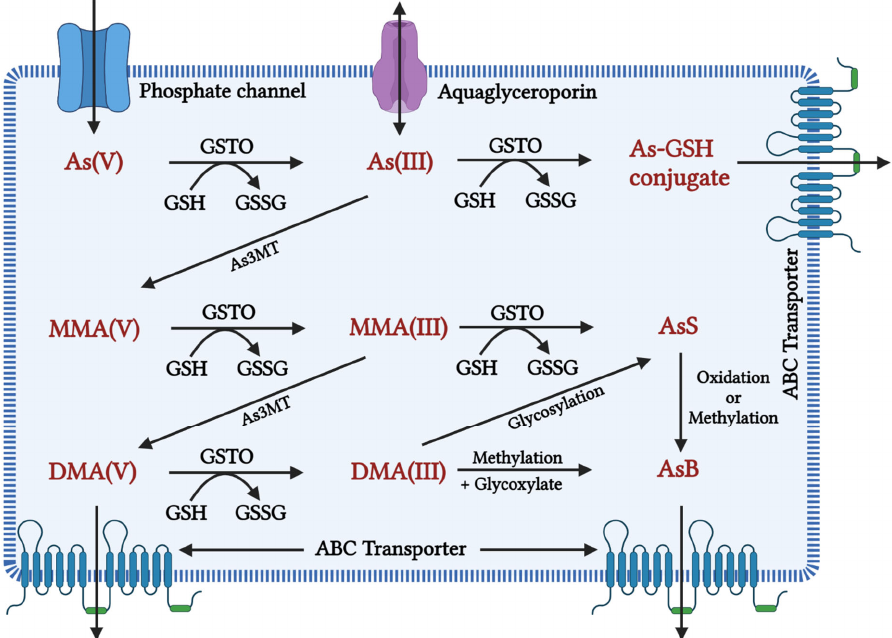
Figure 1. Inorganic arsenic conversion pathways into mono-, di-, and trimethylated products when the toxic form of As(III) is taken up by a cell, it is methylated to MMA (monomethylarsonic acid) and DMA (dimethylarsinic acid) with the help of the enzyme arsenic methyl transferase (AsMT) and can then be eliminated from the body through urine. However, in a pathological state, SAM depletion causes As(III) aggregation, affecting cellular homeostasis in a variety of ways, including oxidative balance, inflammation, and genetic and epigenetic processes. This disruption in home- ostasis causes cellular damage and, eventually, cell death. As(V): inorganic pentavalent